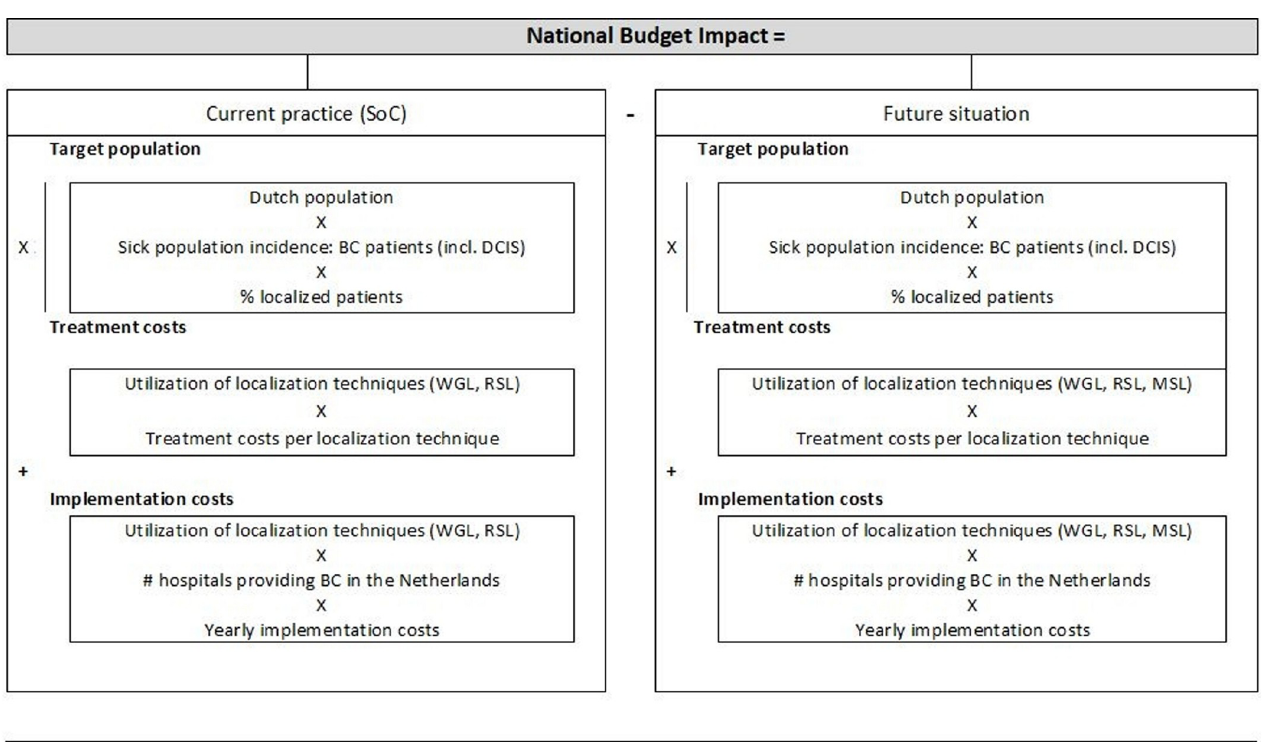
Fig 1. Structure of the Budget Impact model. This national BIA model compares the costs of the current use of localization techniques (RSL and WGL) in the Dutch population with the costs of a future situation in which MSL is adopted. Abbreviations: BC = breast cancer, DCIS = ductal carcinoma in situ, WGL = wire-guided localization, RSL = radioactive seed localization, MSL = magnetic seed localization.